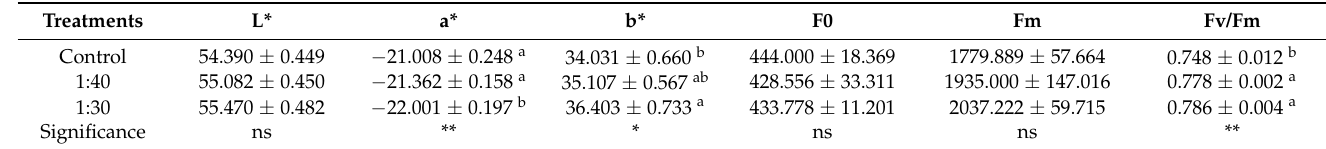
Table 2. Effect of Moringa oleifera leaf extract (MLE) foliar application on chromatic coordinate (L*, a*, and b*), minimum fluorescence (F0), maximal fluorescence (Fm), and maximum quantum efficiency of PSII (Fv/Fm) of radish baby leaf. MLE extract was sprayed 15 and 30 days after planting and 2 days before harvesting (45 days after